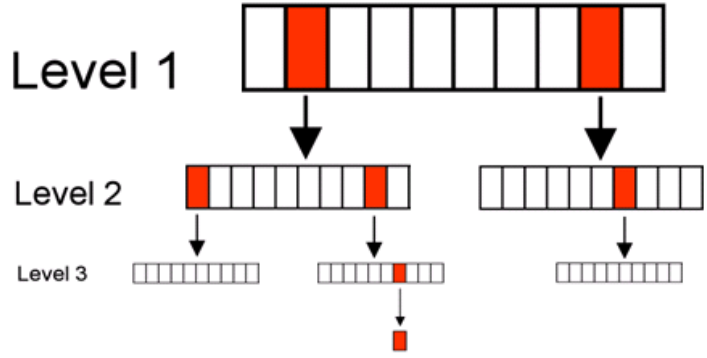
Figure 8. Schematic example of setting a parameter with the mesh search